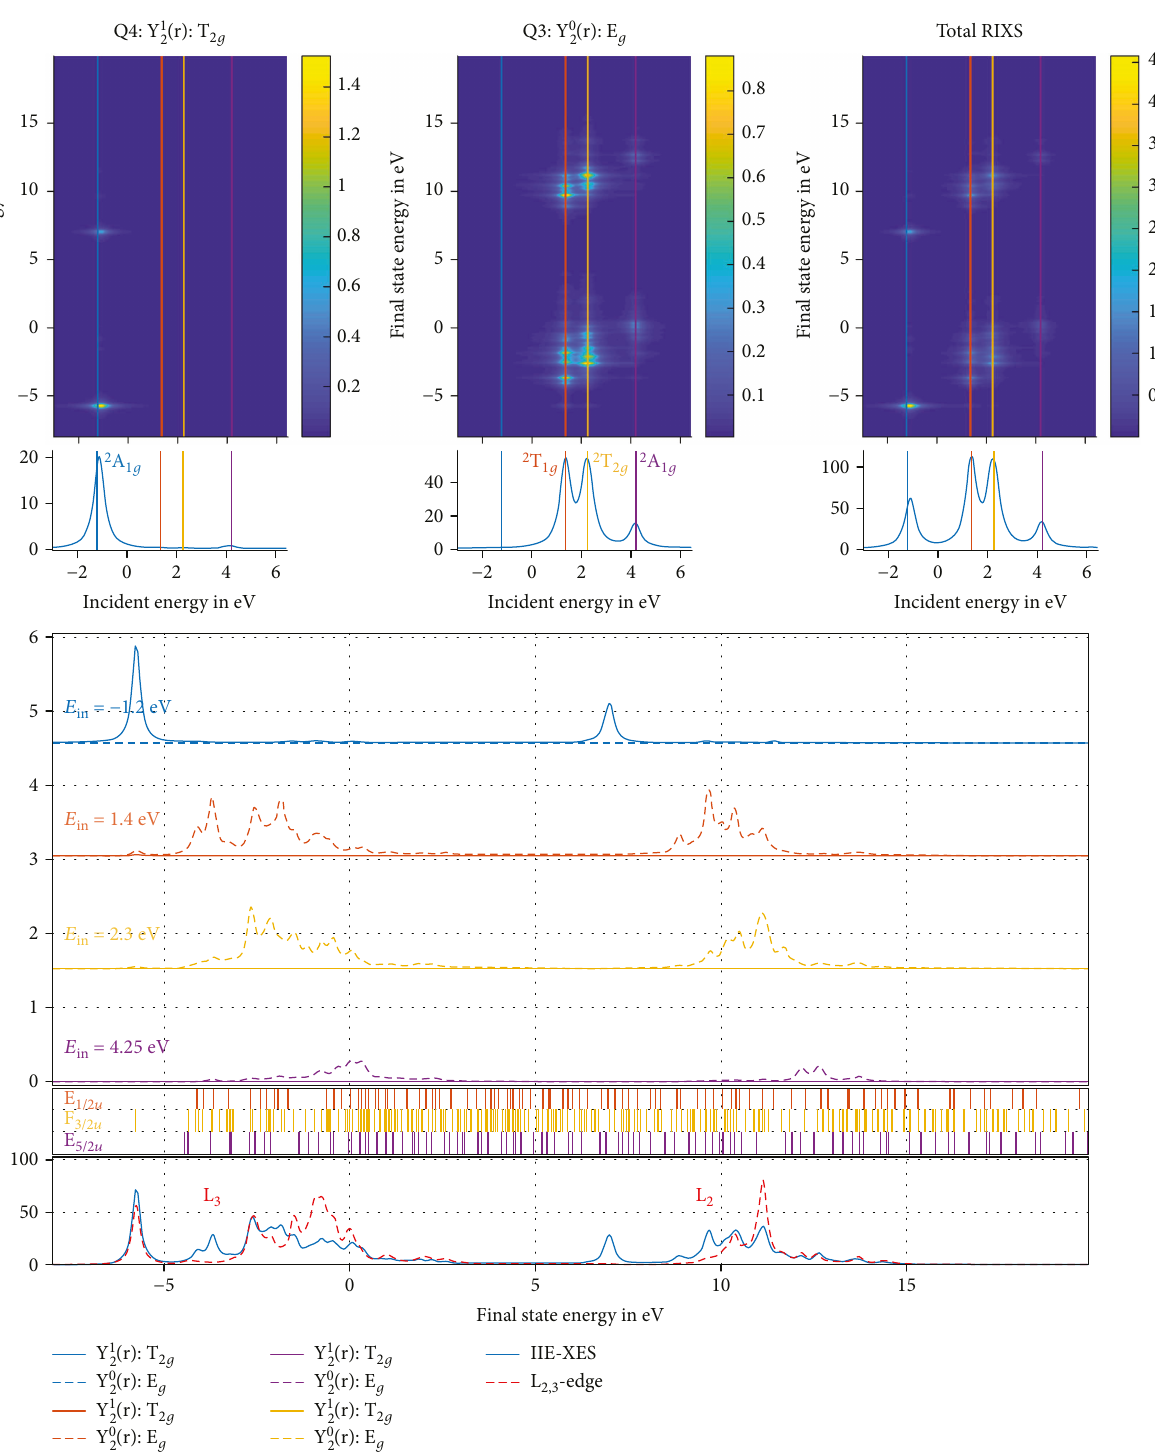
Figure 43: Calculated 1s2p RIXS spectrum for Fe 3+ ( 3d 5 ) for 10D q = 3 9eV (low